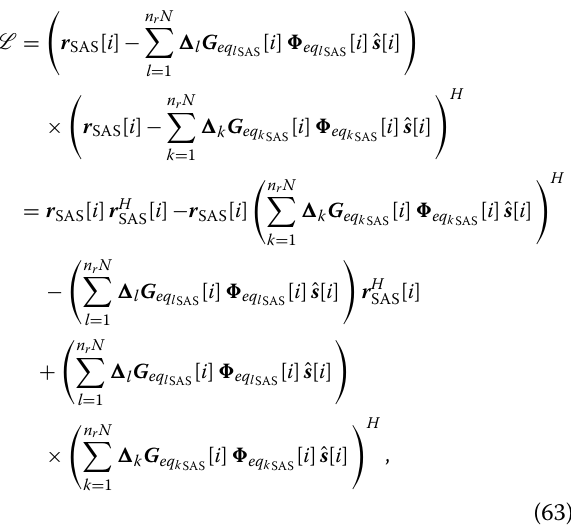
SAS according to the opportunistic relaying